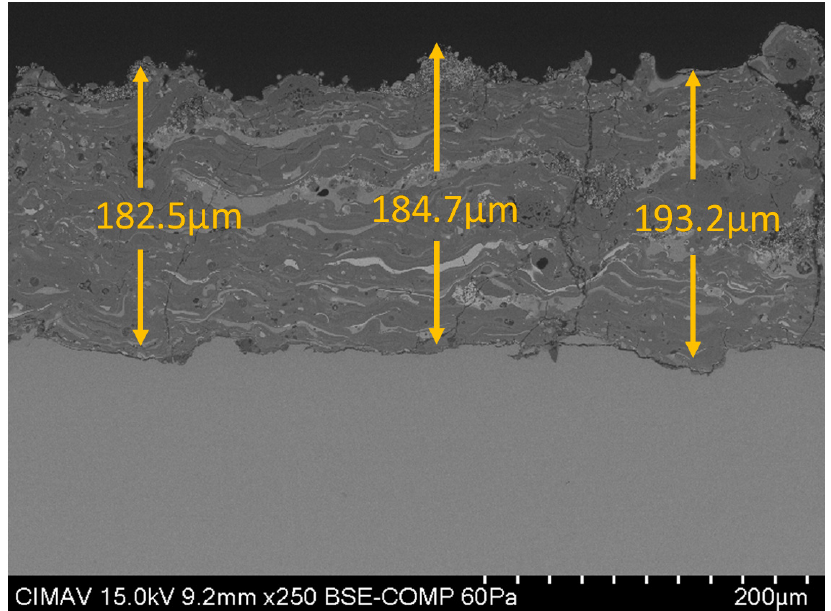
Figure 8. Cross-section SEM micrography of HA30BT HEBM coating.